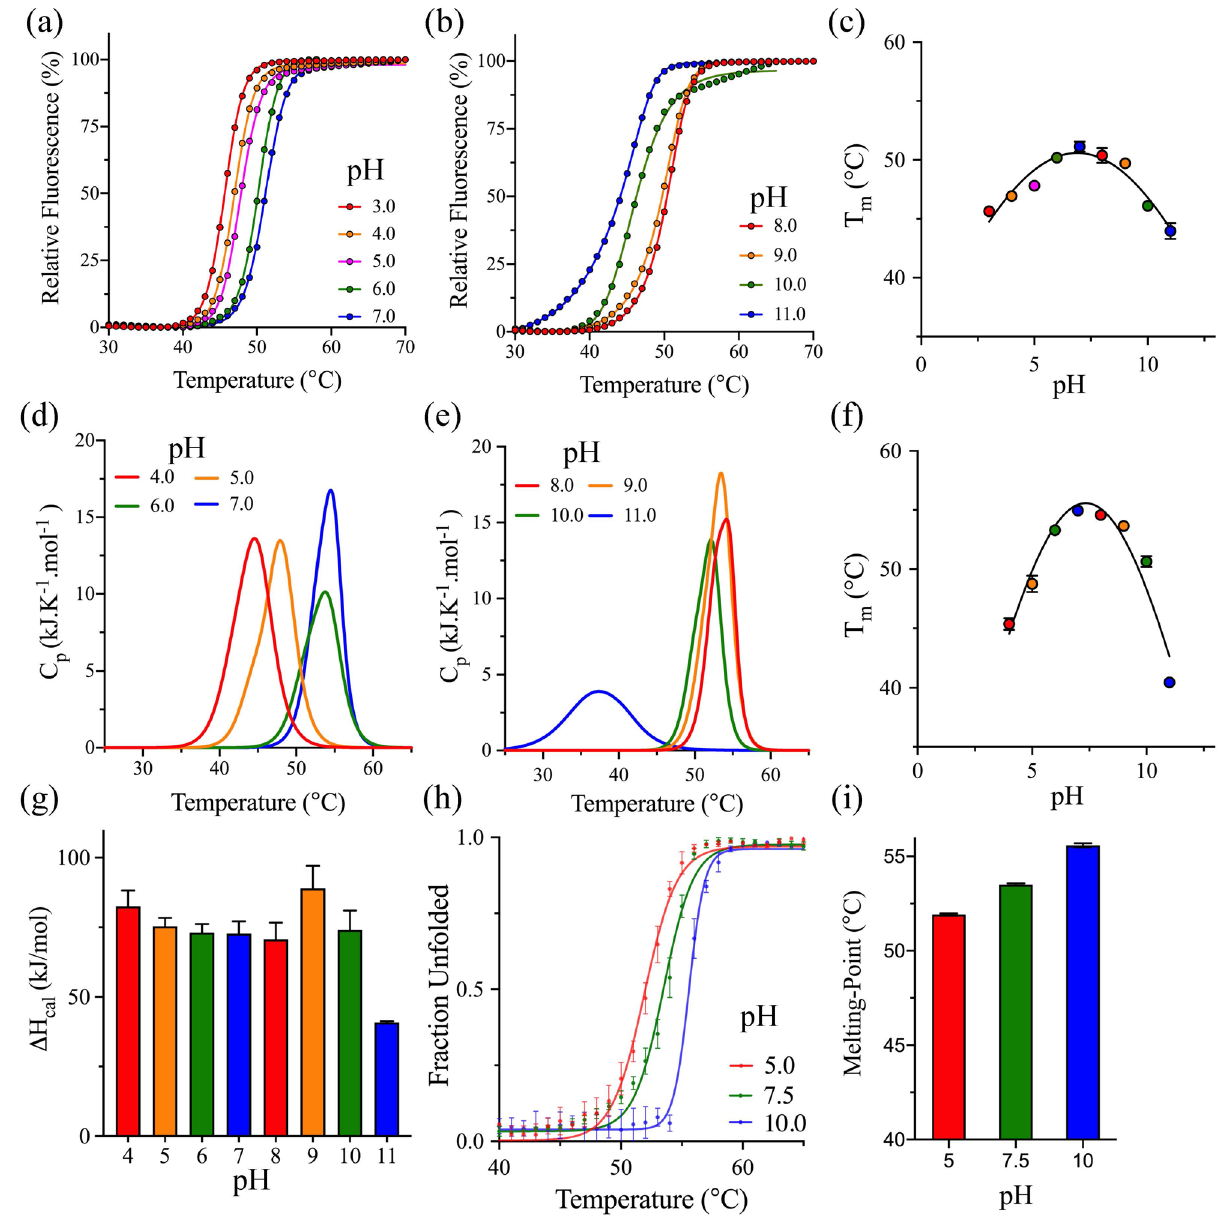
Figure 3. pH effect on the thermodynamic stability of 3CLpro. ( a–b ) DSF thermal scans of 3CLpro at different pH values from 3.0 to 11.0 in 100 mM phosphate buffer without the addition of salt. The DSF scans were collected in the presence of SYPRO Orange dye with an increase in florescence upon the binding of the hydrophobic surfaces of the protein to the dye. ( c ) pH dependence of T m calculated from the midpoint of the thermal transitions of the DSF thermal scans of 3CLpro in panels A and B. Data are mean ± SD, n = 4. ( d–e ) DSC thermograms of 3CLpro in 100 mM phosphate buffer at different pH values from 4.0 to 11.0 in the absence of salt. Two separate DSC scans have been collected for each pH value with high reproducibility. ( f ) pH dependence of T m calculated from the apex of the thermograms of 3CLpro from panels ( d ) and ( e ). ( g ) Bar plot of ΔH cal at different pH values determined from the area under the thermographic peaks in panels ( d ) and ( e ). Data are mean ± SD, n = 2. ( h ) Thermal denaturation profiles of 3CLpro monitored by recording the ellipticity at 222 nm at pH 5.0 (red), 7.5 (green), and 10.0 (blue). The sample was heated at a rate of 1.0 °C/min, and T m was calculated from the midpoint of the thermal transitions. ( i ) Bar plot of T m calculated from the midpoint of the thermal transitions monitored by CD. Data are mean ± SD, n =